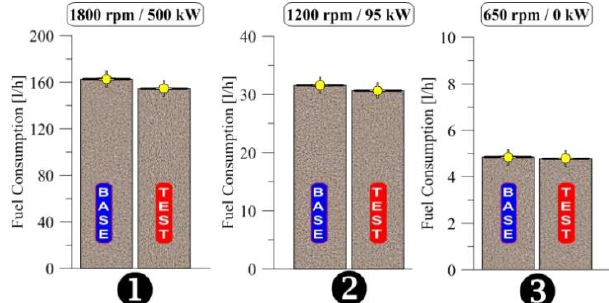
Fig. 9. Measurement of hourly fuel consumption FC [l/h] of a CAT C27 engine (6Dg locomotives) with additive. Test F, point 